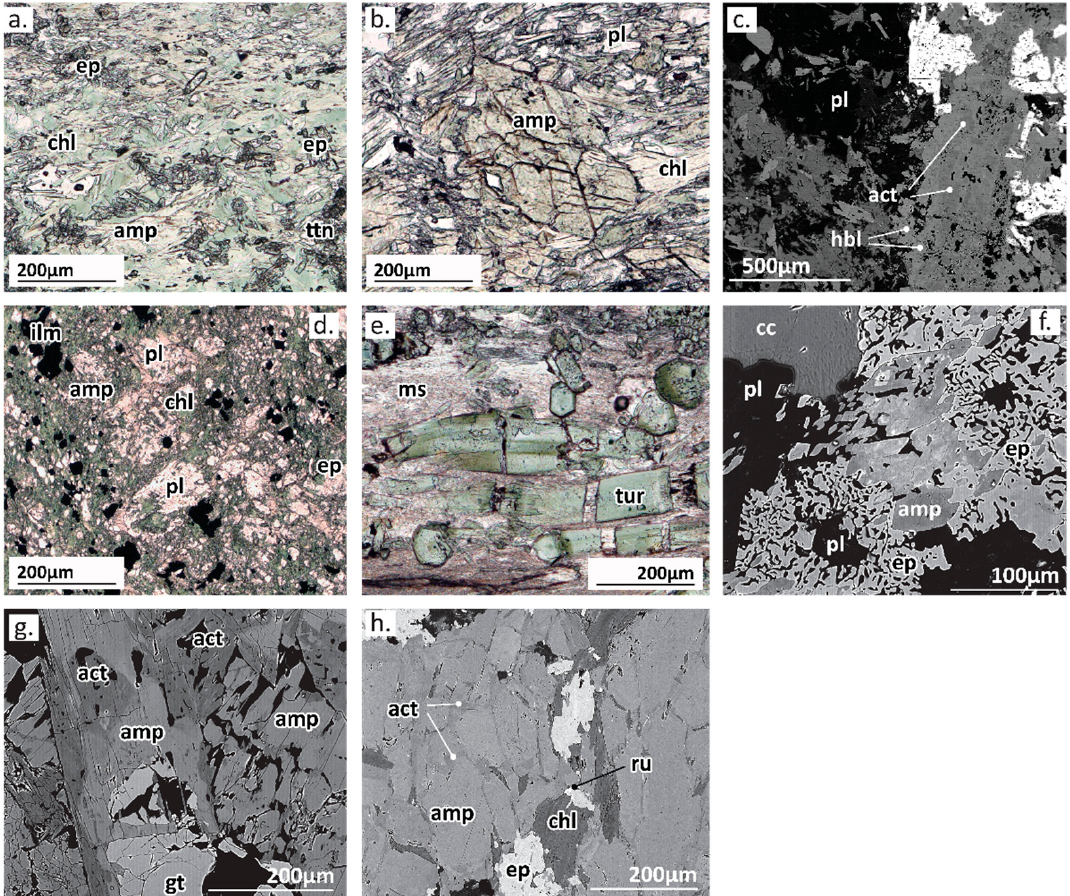
Figure 3. Micrographs and backscattered electron images of characteristic textures in Tartoq belt rocks; ( a ) Typical Nuuluk greenschist with chlorite, epidote, plagioclase, quartz, titanite and relics of amphibole and ilmenite; ( b ) Greenschist from southern Iterlak showing an amphibole porphyroblast; ( c ) Prograde actinolite rimmed by magnesio-hornblende in a Nuuluk greenstone; ( d ) Retrograded Iterlak gabbro with dark green amphibole being replaced by lighter green chlorite, but with preservation of the gabbroic texture; ( e ) Concentrically and sector zoned tourmaline in a sample of fuchsite schist adjacent to a quartz-ankerite vein in the Eastern Carbonate Zone of Nuuluk; ( f ) Typical texture of the actinolite–epidote–titanite retrogression stage; ( g ) Texture of a calc-silicate sample from Bikuben with retrograde replacement of hornblende by actinolite; ( h ) Well preserved amphibolite. Thin rims of actinolite and a vein of chlorite and epidote mark later retrogression. Mineral abbreviations used: amp = hornblende amphibole; act = actinolite; chl = chlorite; ep = epidote; ttn = titanite, cc = calcite; pl = plagioclase; gt = garnet, tur = tourmaline, ru = rutile; ilm = ilmenite; ms = muscovite.